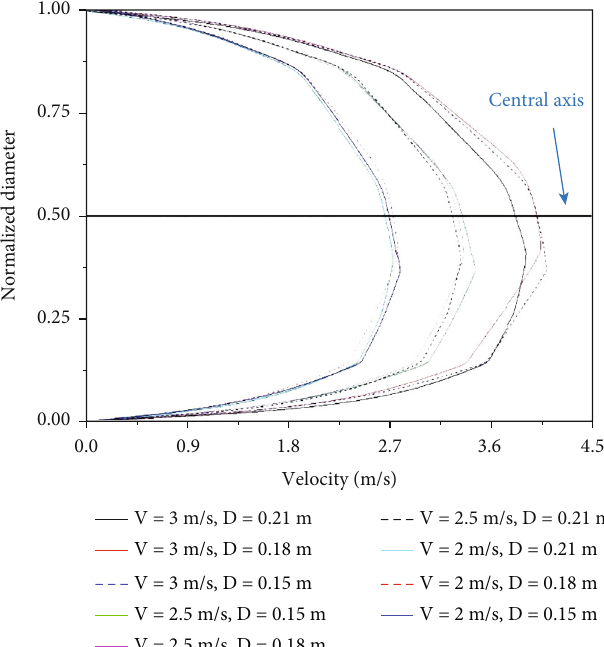
Figure 8: Velocity contour of the observation plane at the bend.